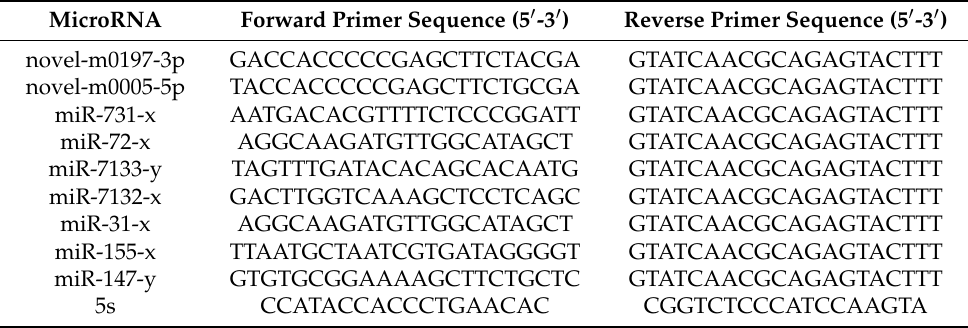
Table 5. List of primers used for qRT-PCR in this study. MicroRNA Forward Primer Sequence (5 (cid:48) -3 (cid:48) ) Reverse Primer Sequence (5 (cid:48) -3 (cid:48) ) novel-m0197-3p GACCACCCCCGAGCTTCTACGA